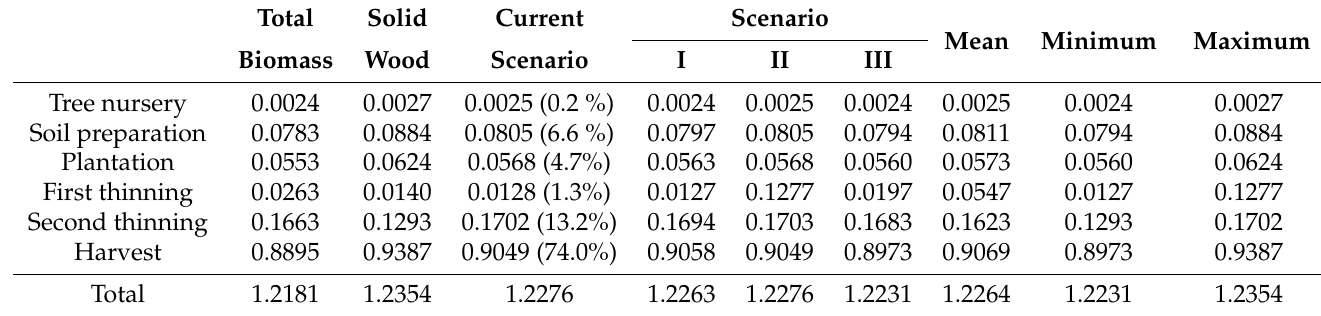
Table 10. Global warming power for 100 years expressed in kg CO 2 − eq m − 3 of wood produced per year. Percentage of carbon footprint of current scenario in